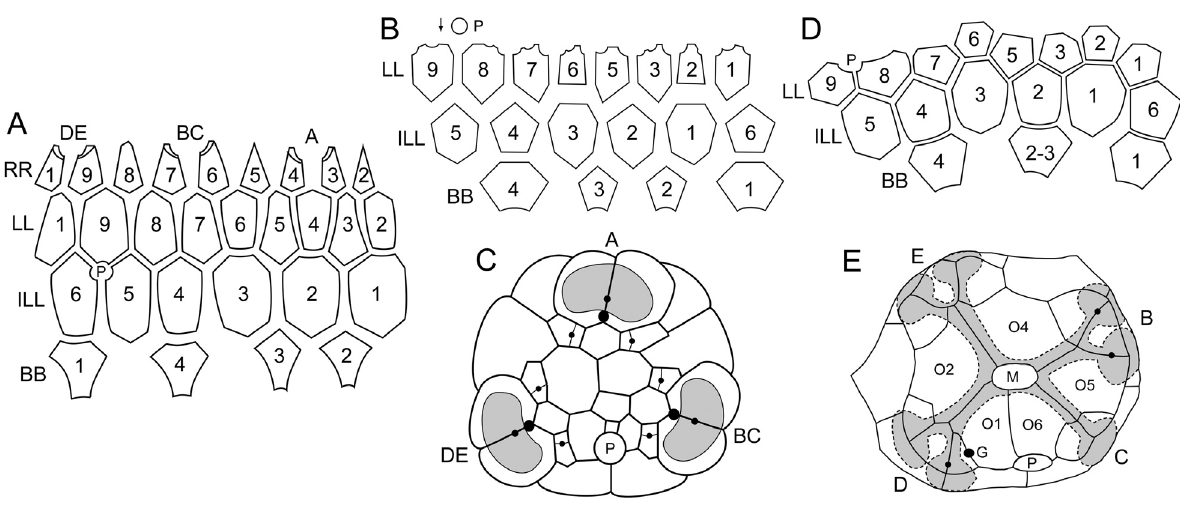
Fig. 9. Standard thecal plate diagrams and oral surfaces to illustrate the main features of the three families of hemicosmitoid rhombiferans. A , Hemicosmites von Buch, 1840. B , Caryocrinites Say, 1825. C , Stribalocystites Miller, 1892. D – E , Thomacystis Paul, 1969. In the Hemicosmitidae ( A ) there are four plate circlets, basals (BB), infralaterals (ILL), laterals (LL) and radials (RR), with 4, 6, 9 and 9 plates each. Conventional notation numbers plates in each circlet from 1, starting with the basal to the left of the periproct (P) and alternating in successive circlets as in glyptocystitoid rhombiferans (Fig. 6). Caryocrinitids ( B , C ) and thomacystids ( D , E ) have only the lower three plate circlets, both lack plate L4 in the lateral circlet and the periproct is on the oral surface ( C , E ). In addition, Thomacystis has only three basals ( D ). Hemicosmitids have three ambulacra always with a single arm facet (A, BC, DE in A ), whereas caryocrinitids may have a single facet per ambulacrum ( C ) or multiple facets in Caryocrinites . Thomacystis has an exposed oral surface with four ambulacra (B–D in E ) and five oral plates (O1, O2, O4–O6). Glyptocystitoids always have six orals and so it is assumed Thomacystis not only lacks ambulacrum A, but the associated plate O3 as well. G, gonopore; M, mouth. Arrow and circle labelled P in B indicate relative positions of the gonopore and periproct in Caryocrinites . Ambulacra and facets shaded in C and E . Redrawn and relabelled from: A , Bockelie (1979, fig. 4A, p. 371); B , Frest (1975, fig. 2, p. 86); C , Frest (1975, fig. 15, p. 103); D , E , Paul (1984, fig. 87, p.